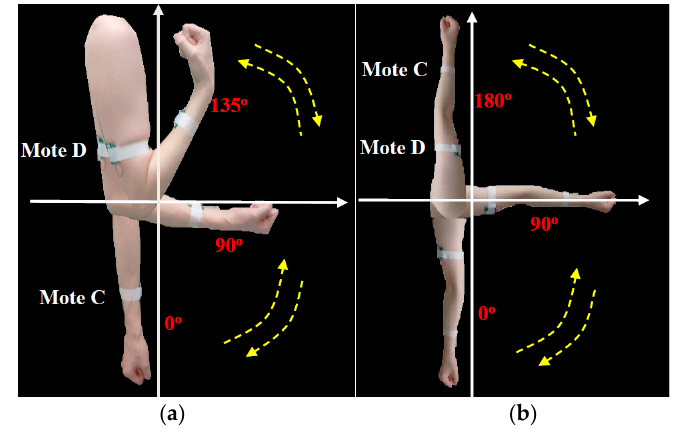
Figure 8. Flexion test for physical therapy: ( a ) flex the elbow (left); ( b ) raise the arm (right).